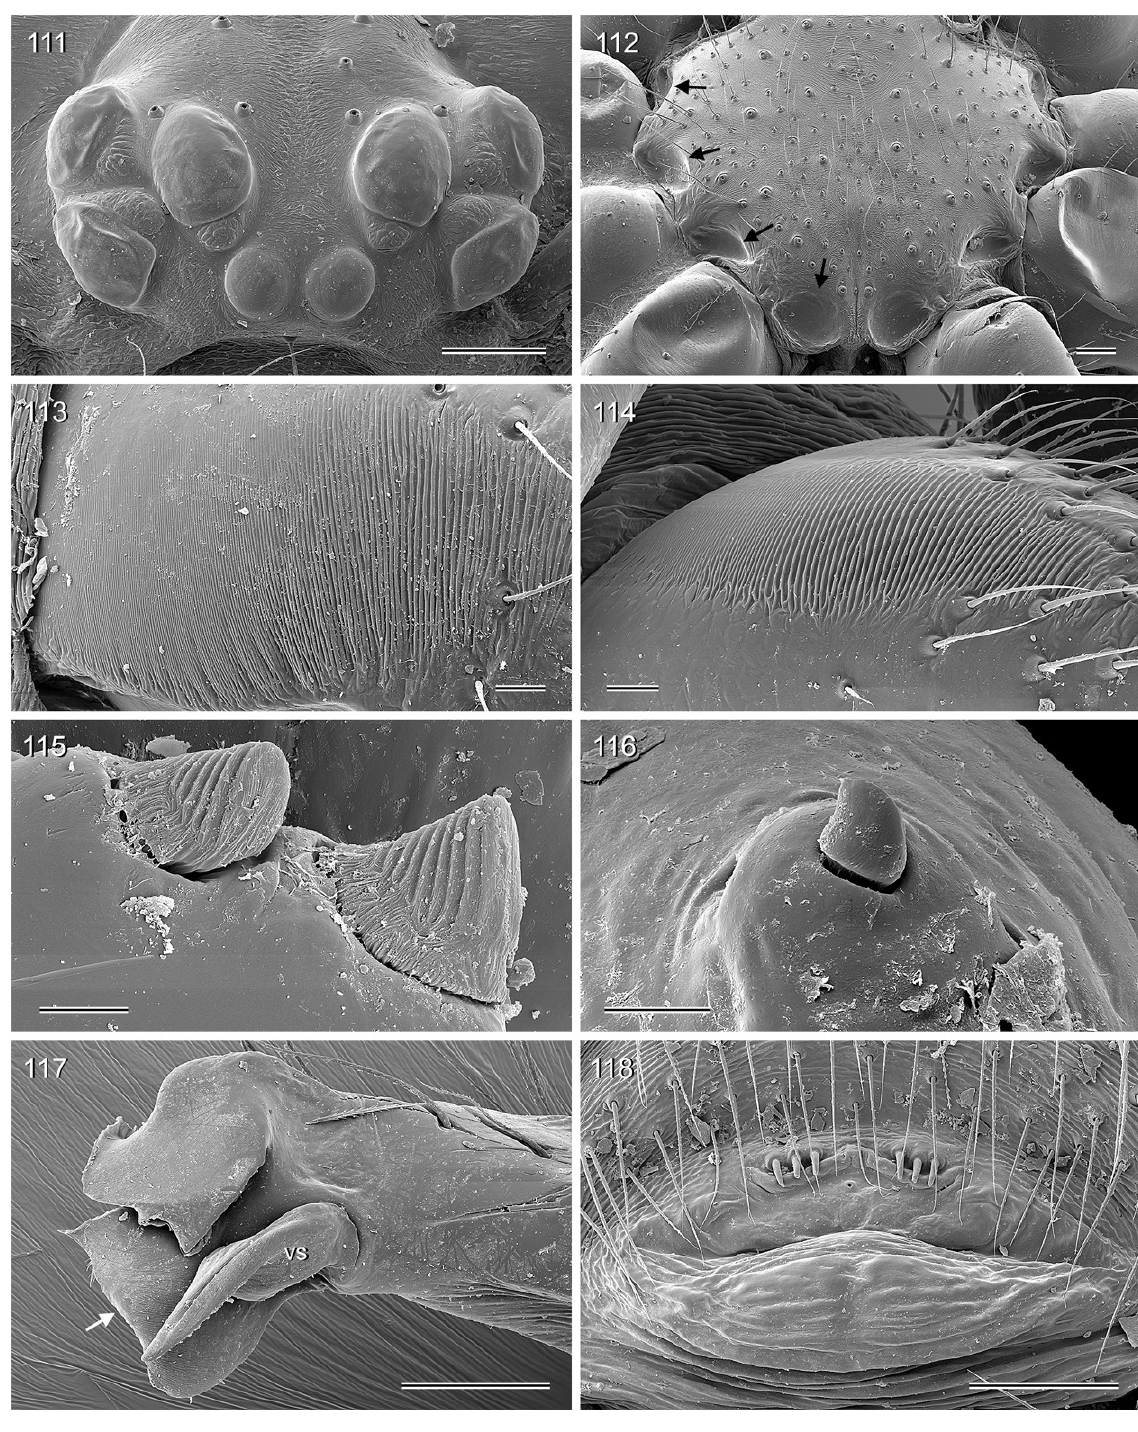
Figs 111–118. Holocnemus caudatus (Dufour, 1820); male and female from Spain, Granada, Trevélez (MHNG). 111 . Female ocular area. 112 . Male sternum; arrows: indentations. 113–114 . Male and female cheliceral stridulatory files. 115 . Modified hairs on male cheliceral apophysis. 116 . Stridulatory pick on male palpal femur. 117 . Right procursus tip, prolateral view; arrow: retrolateral membrane. 118 . Male gonopore. Abbreviation: vs = ventral sclerite. Scale bars: 111–112, 117–118 = 100 µm; 113–114 = 20 µm; 115–116 = 10